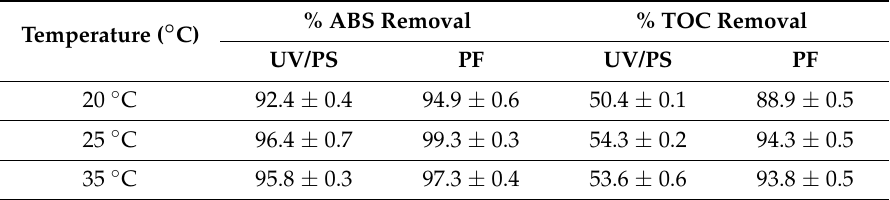
Table 1. Effect of temperature on UV/PS and photo-Fenton efficiencies during the degradation of TA for 2 h UV irradiation. (UV/PS: [K 2 S 2 O 8 ]/[TA] = 531, pH = 9 and T = 20–35 ◦ C; UV/H 2 O 2 /Fe 2+